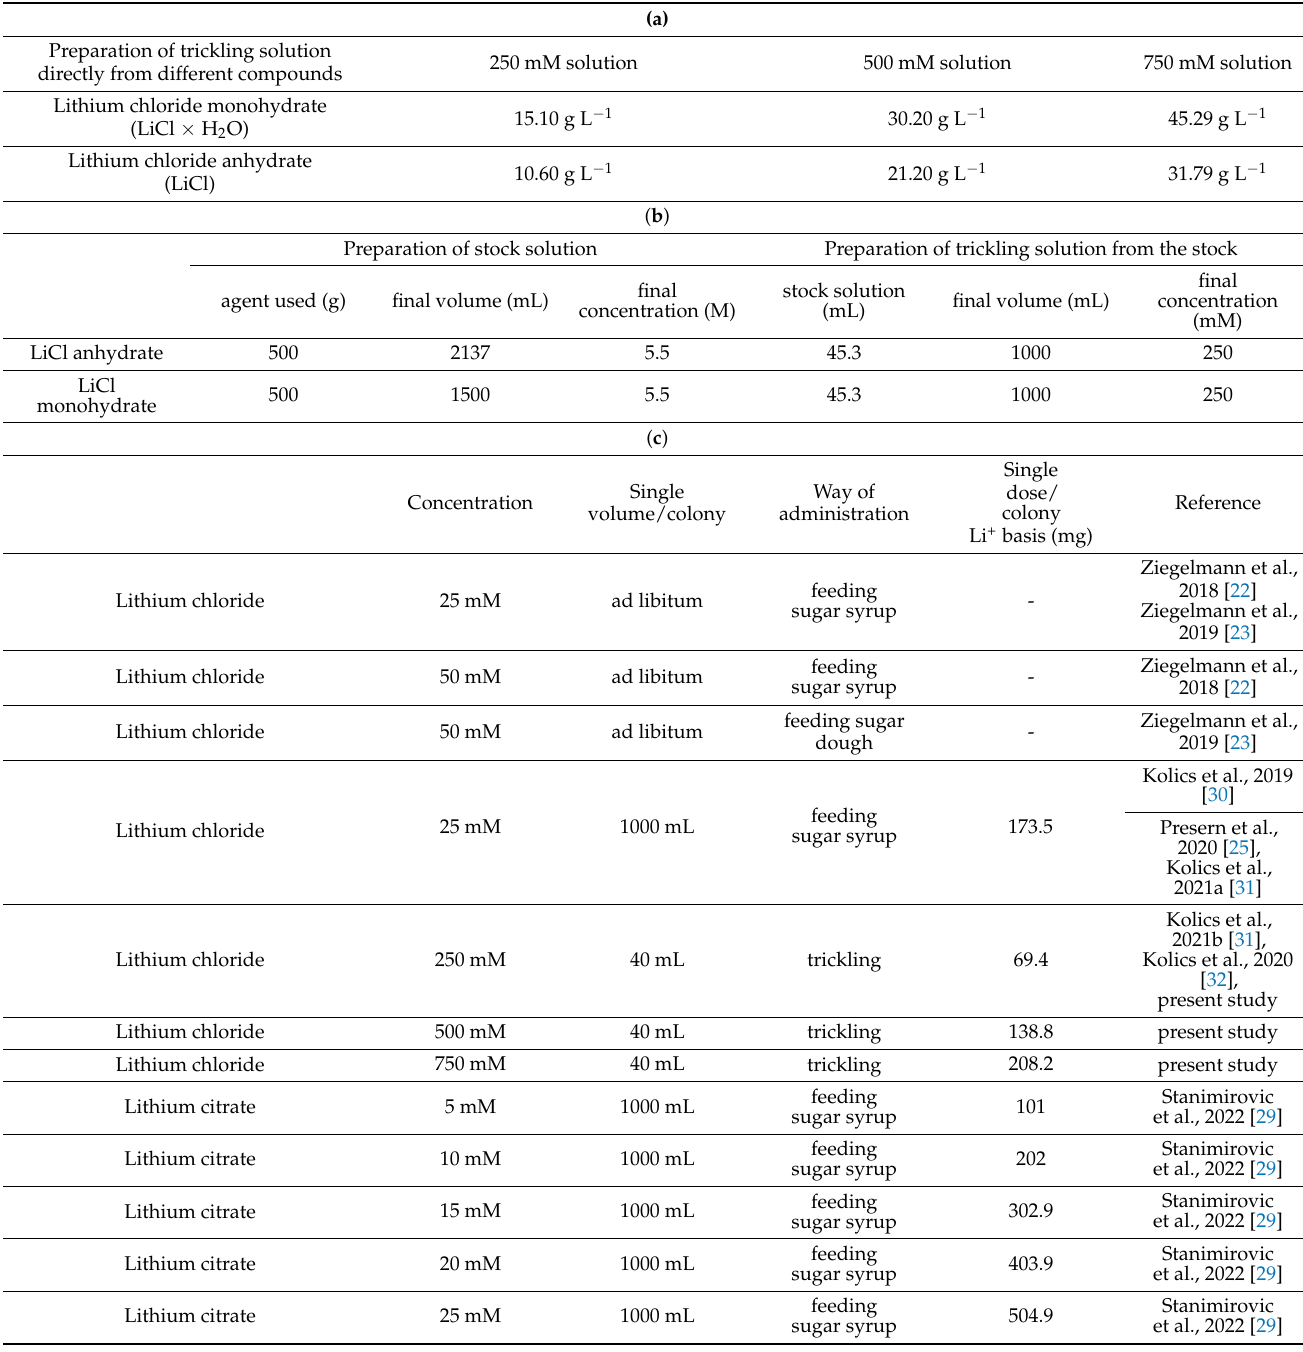
Table 2. ( a ) Preparation of the trickling solution of different concentrations; ( b ) preparation of the trickling solution from stock solution; and ( c ) concentration of trickling solutions in comparison with previous studies.